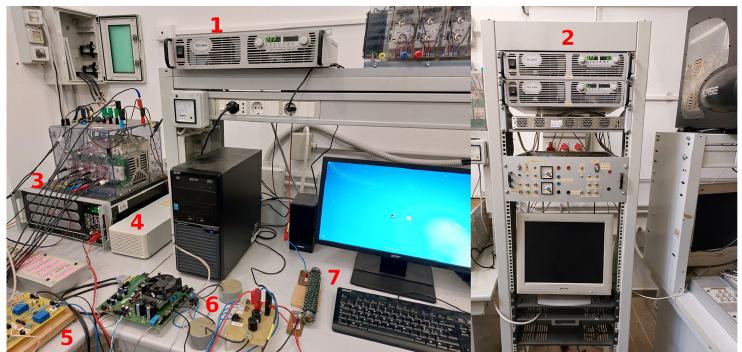
Figure 9. Photo of the experimental setup: ( 1 ) TDK-Lambda GEN60-40 grid-side power supply; ( 2 ) TDK-Lambda GEN600-5.5 storage-side power supply; ( 3 ) Sorensen SLH-500-6-1800 electronic load; ( 4 ) dSPACE DS1103 board; ( 5 ) LEM-based measuring circuits; ( 6 ) Split-pi prototype (including the inductors and the grid-side external capacitor); ( 7 ) droop resistor of the grid-side power supply (only used in Scenario #3).